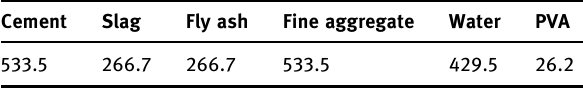
Table 4: The mixture ratio of SHCC ( kg · m − 3 )